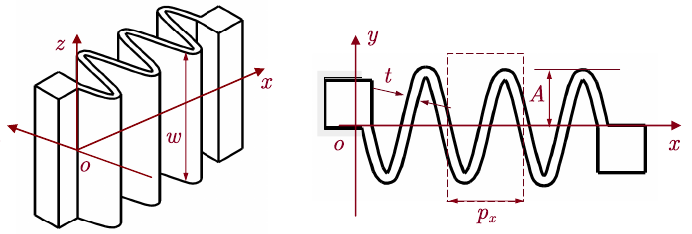
Figure 1. Structure of the sinusoidal corrugated flexure linkage with n = 3 for